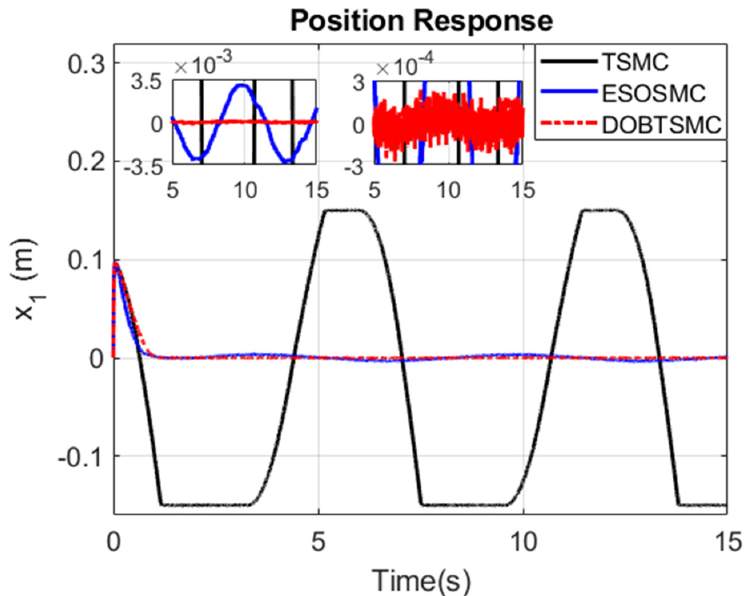
Figure 8. Position response of the EHA system.